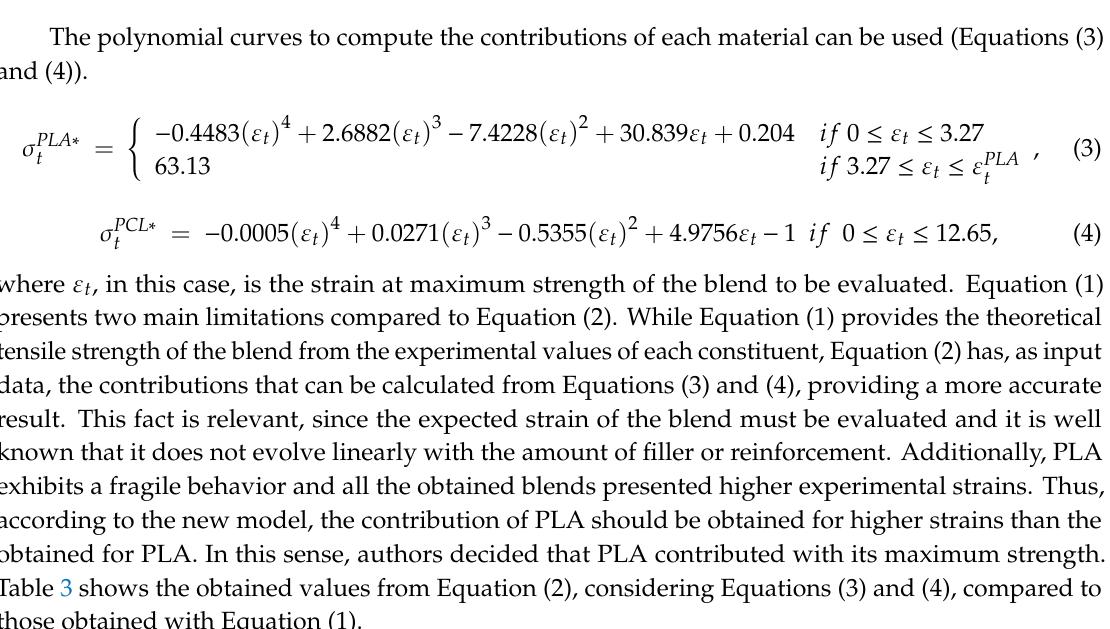
Figure 5. Stress-strain curves of the PLA / PCL blends and PLA and PCL matrices.